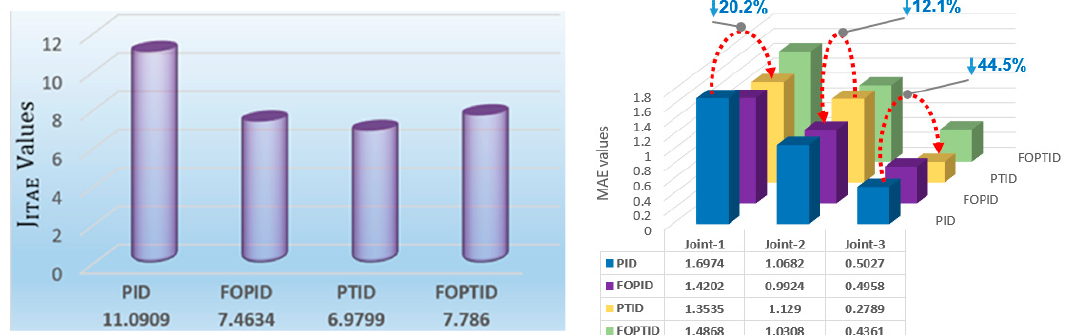
Figure 16. Comparison diagram of tracking error evaluation indicators based on J ITAE and MAE values for the presented controllers.